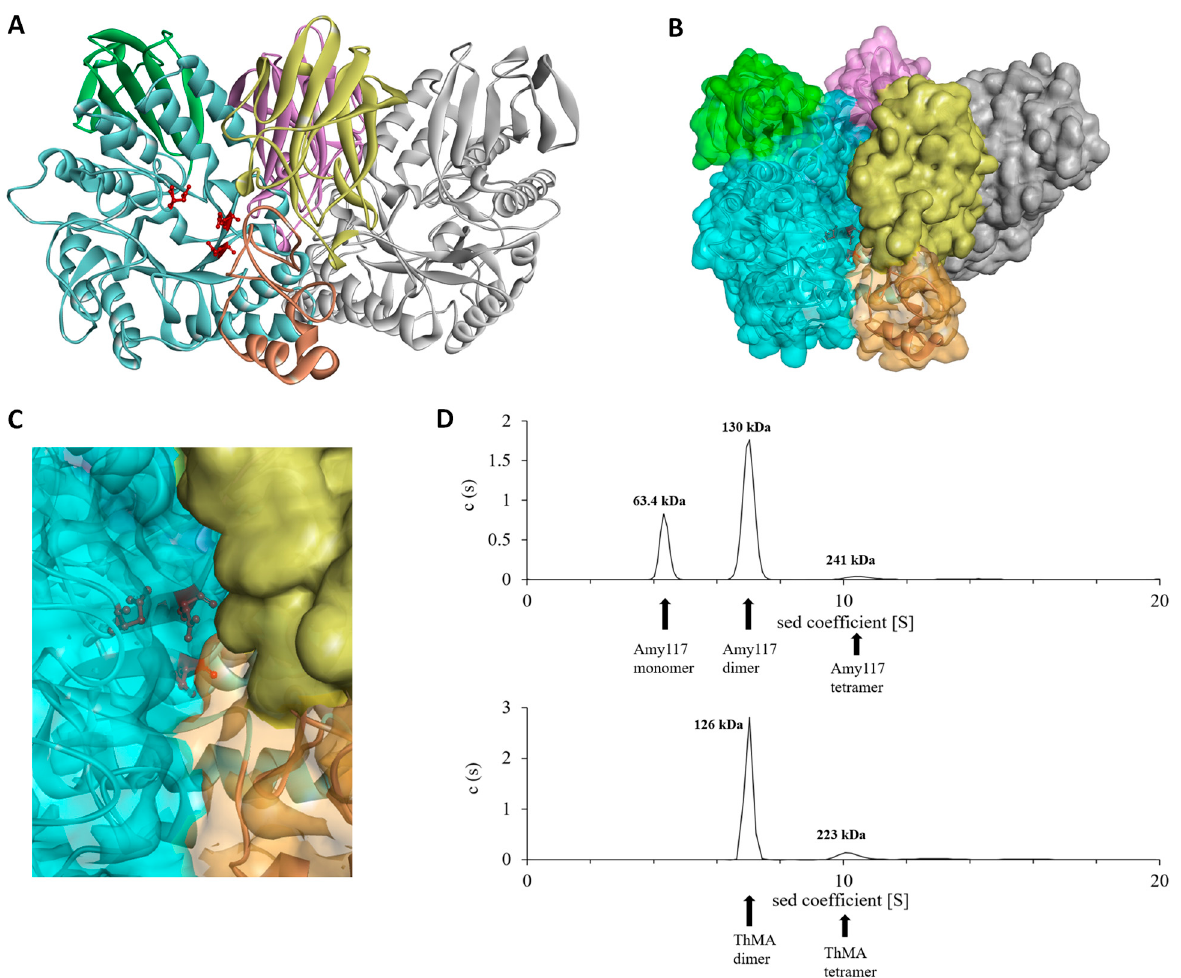
Figure 5. The simulated structure of Amy117. ( A ) The overall dimer structure of Amy117 is shown by the cartoon model; ( B ) Surface representation of Amy117; ( C ) Detailed view of the catalytic cleft. One monomer in the dimer structure is colored yellow (Domain N) and gray, and the domains N, A, B, C of the other monomer are colored purple, blue, brown, and green, respectively. Three catalytic residues, Asp333, Glu362, and Asp429, are presented as ball-and-stick models and colored red; ( D ) Analytical ultracentrifugation of Amy117 and ThMA.